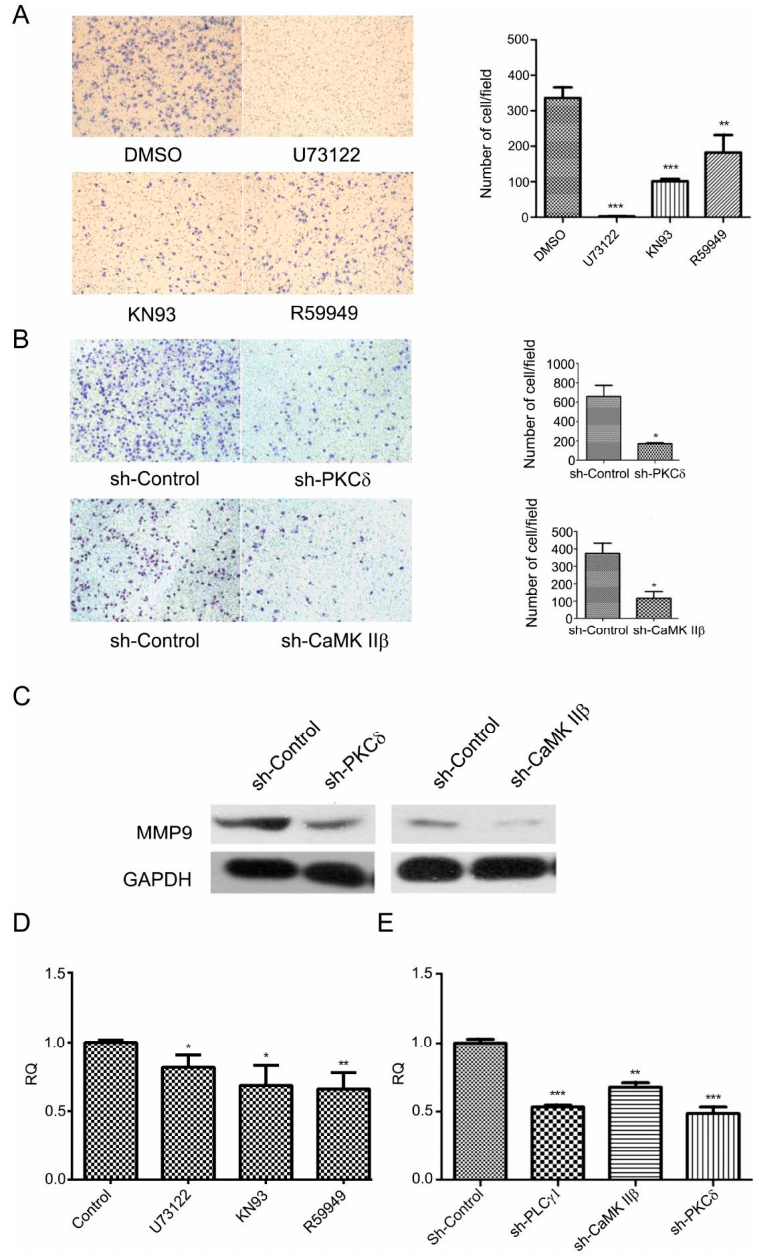
Figure 2. The effect of inhibiting CaMK II β and DAG/PKC δ on cell migration in human gastric adenocarcinoma cells. ( A ) Cells were treated with DMSO (2 μ L), U73122 (10 μ M), KN93 (16 μ M), and R59949 (20 μ M) for 3 h, respectively. The migration ability were measured by a transwell assay as described in Materials and Methods (magnification 200×); ( B ) Cells were transfected with sh-PKC δ -2 or sh-CaMK II β -1 vectors for 48 h, and the migration ability were measured by a transwell assay as described in Materials and Methods (magnification 200×); ( C ) Cells were transfected with sh-PKC δ -2 and sh-CaMK II β -1 vectors for 48 h. The expression level of MMP9 was determined by Western blotting analysis as described in Materials and Methods. Glyceraldehyde-3-phosphate dehydrogenase (GAPDH) was used as an internal control; ( D ) Cells were treated with DMSO (2 μ L), U73122 (10 μ M), KN93 (16 μ M), or R59949 (10 μ M), respectively. The mRNA levels of MMP9 were measured by RT-PCR analysis as described in Materials and Methods; ( E ) Cells were transfected with sh-PLC γ 1, sh-PKC δ -2, or sh-CaMK II β -1 vectors for 48 h. The mRNA levels of MMP9 were measured by RT-PCR analysis as described in section Materials and Methods. Data are expressed as mean ± S.D. of three independent experiments, each yielding similar results (* p < 0.05, ** p < 0.01, *** p < 0.001, versus control).